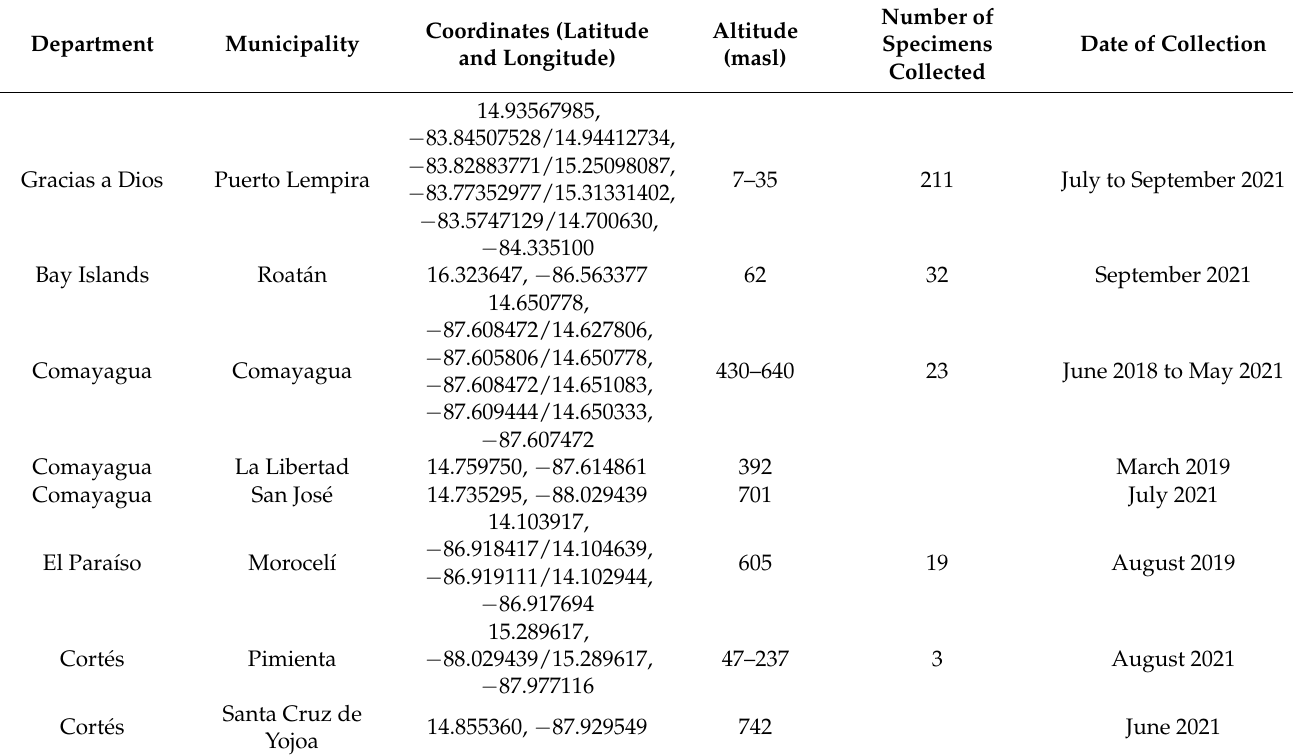
Table 1. Collection sites’ coordinates, altitude, date of collection, and number of Anopheles mosquitoes